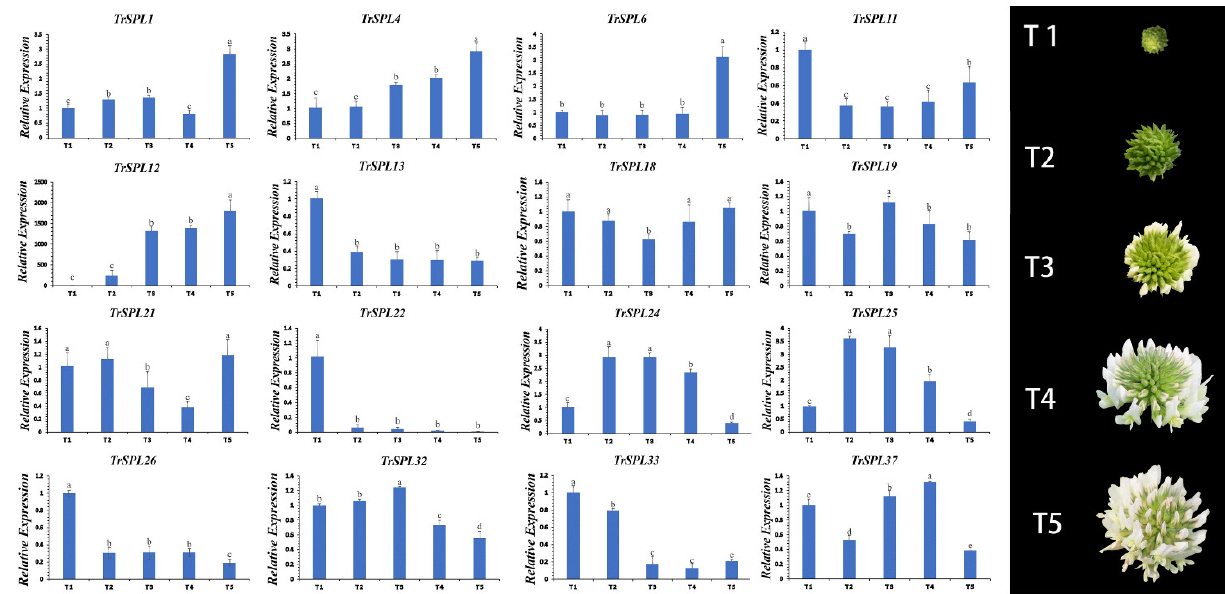
Figure 8. Expression profiles of 16 selected TrSPL genes at 5 different flower development stages in T. repens . T1, Immature inflorescence; T2, Inflorescences in which no floret was open; T3, Inflorescences in which outermost circle of florets were open; T4, Inflorescences in which 50% of florets were open; and T5, Mature inflorescence. The vertical bar is the standard deviation. The letters indicate